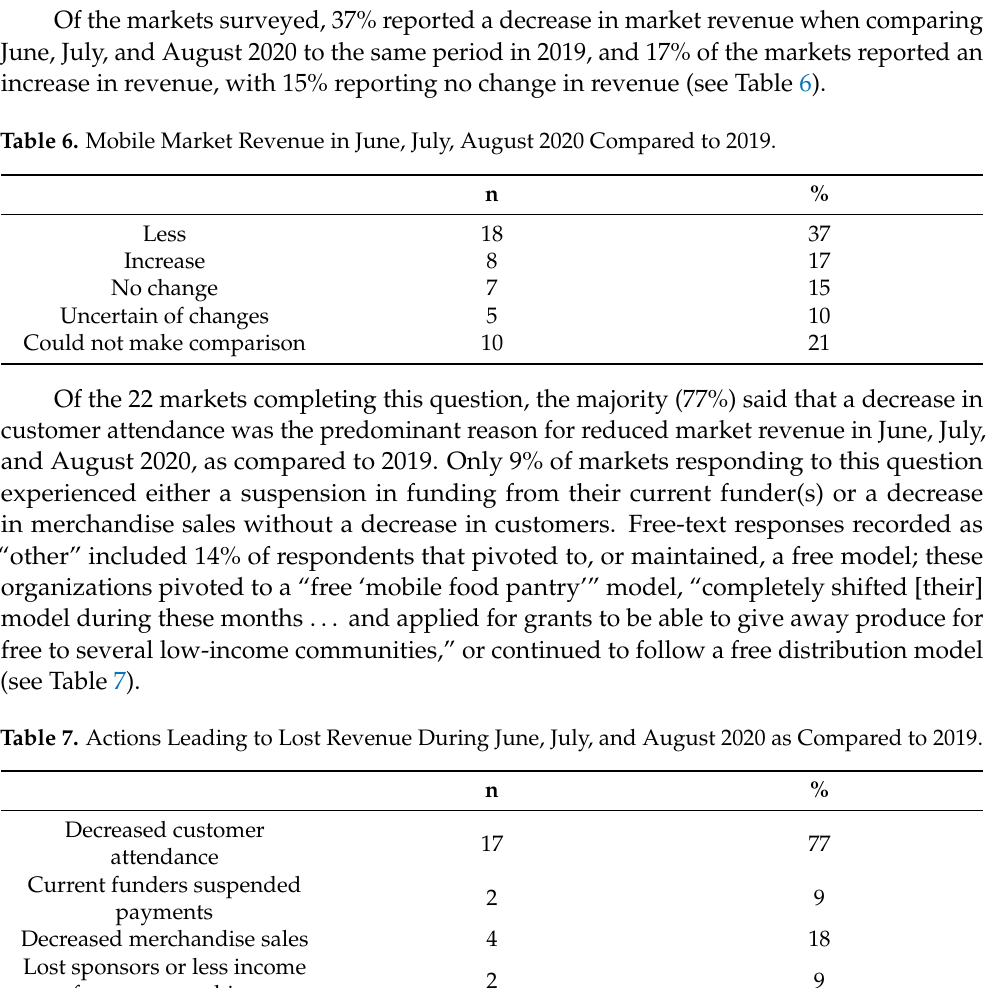
Table 6. Mobile Market Revenue in June, July, August 2020 Compared to 2019.